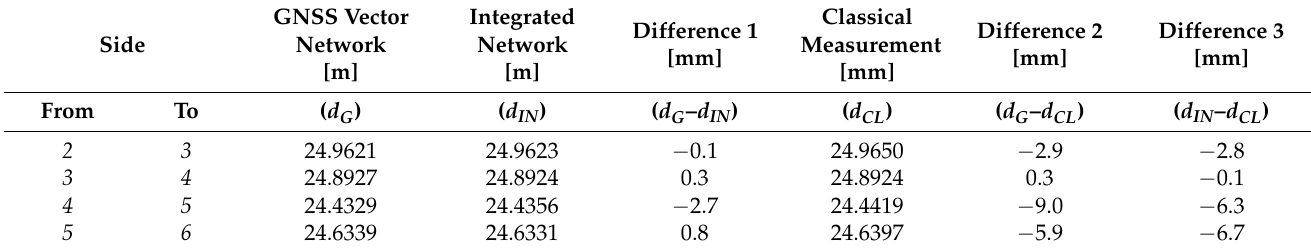
Table 9. Comparison of spatial distances following the